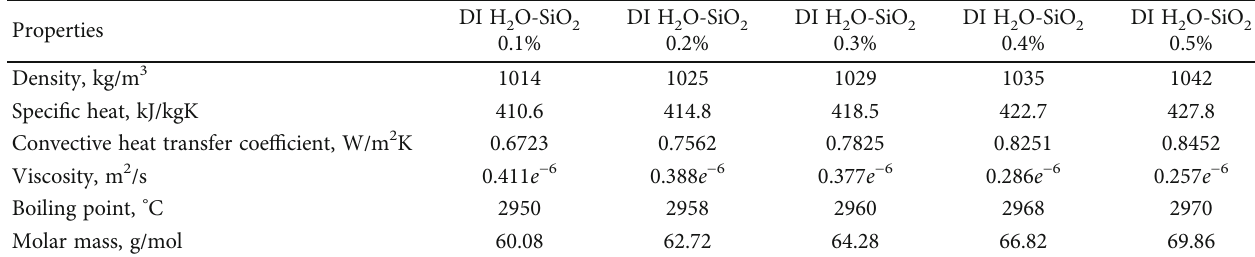
Table 3: Properties of nano fl uids.